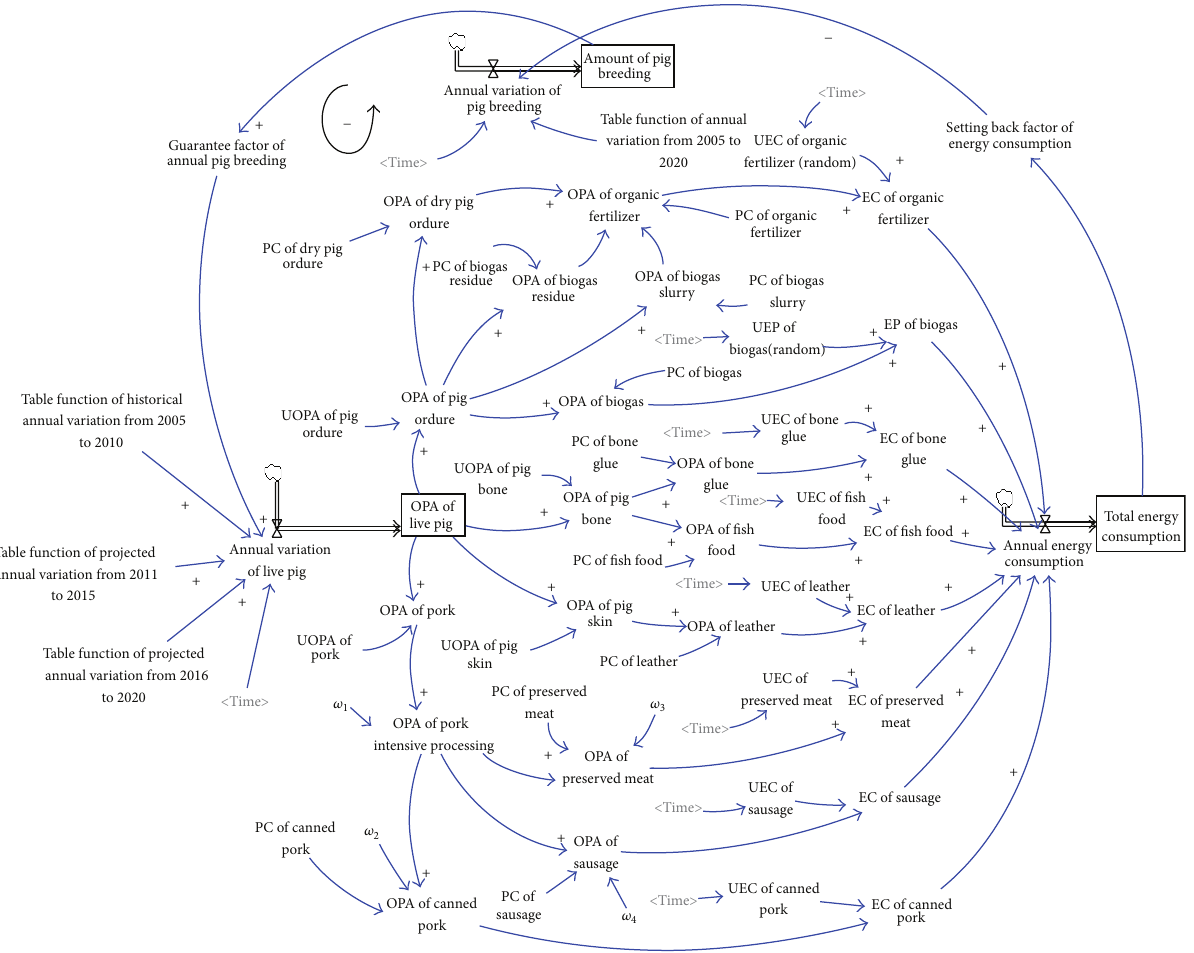
Figure 3: The energy consumption of the pig industry